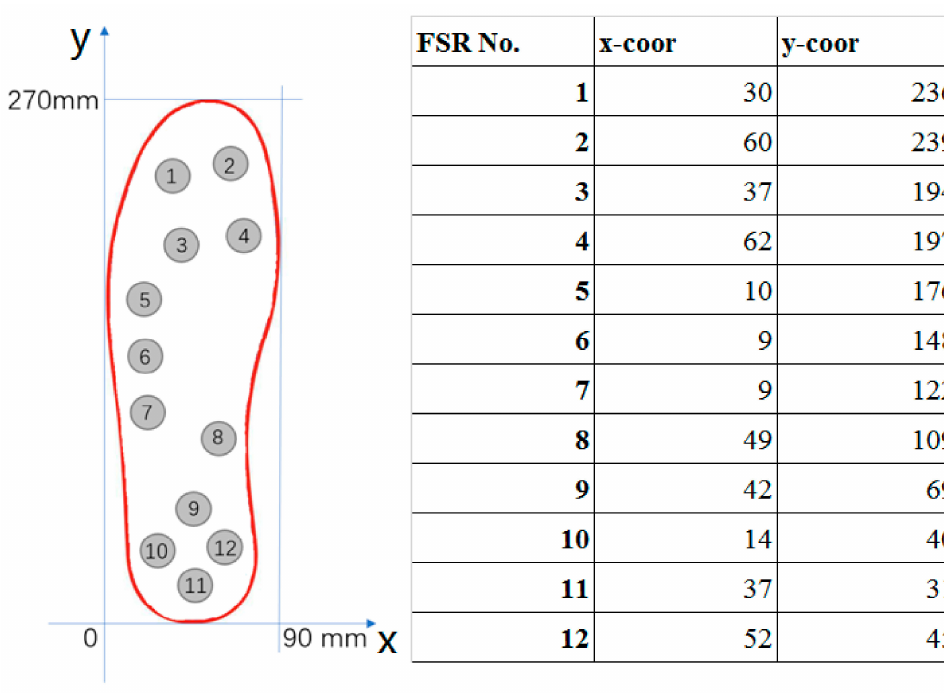
Figure 1. The block diagram of the instrumented insole.